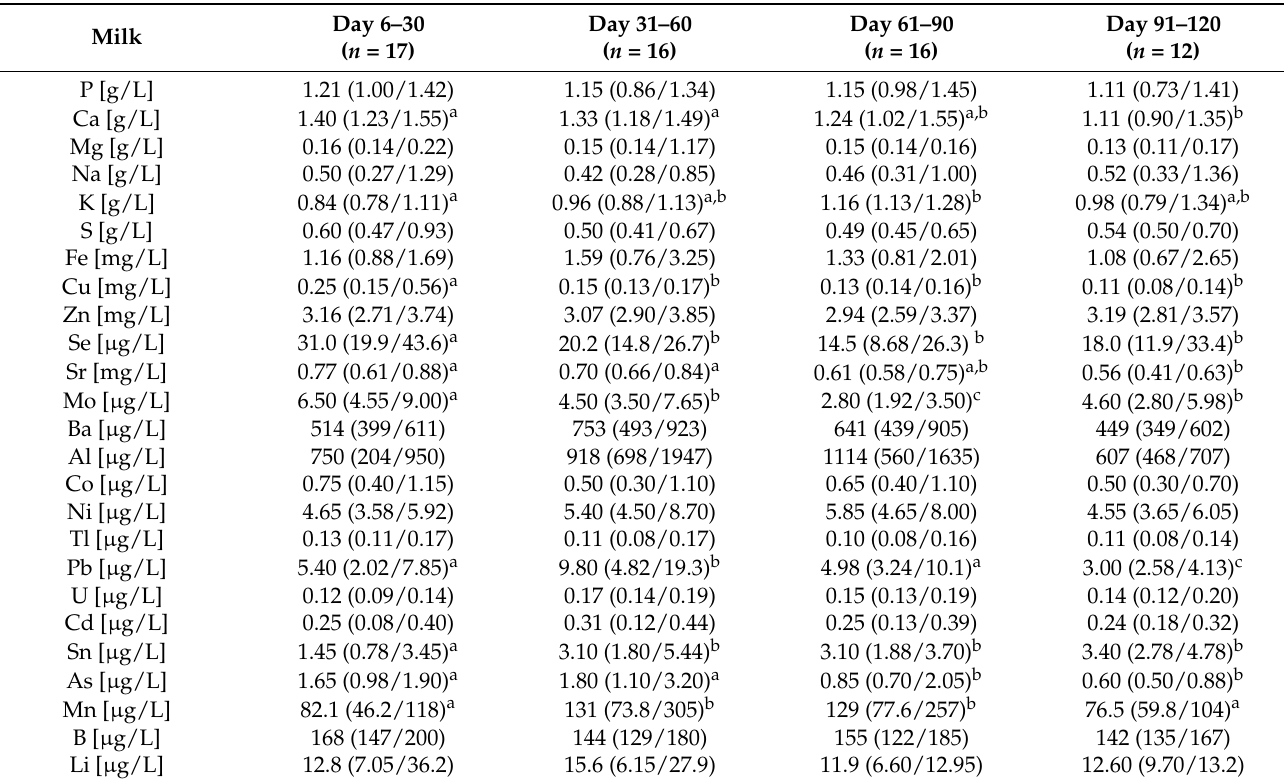
Table 5. Concentrations of macro and trace elements in alpaca milk during four months postpartum, data are provided as median (1st quartile/3rd quartile), significant differences between the months are marked with different